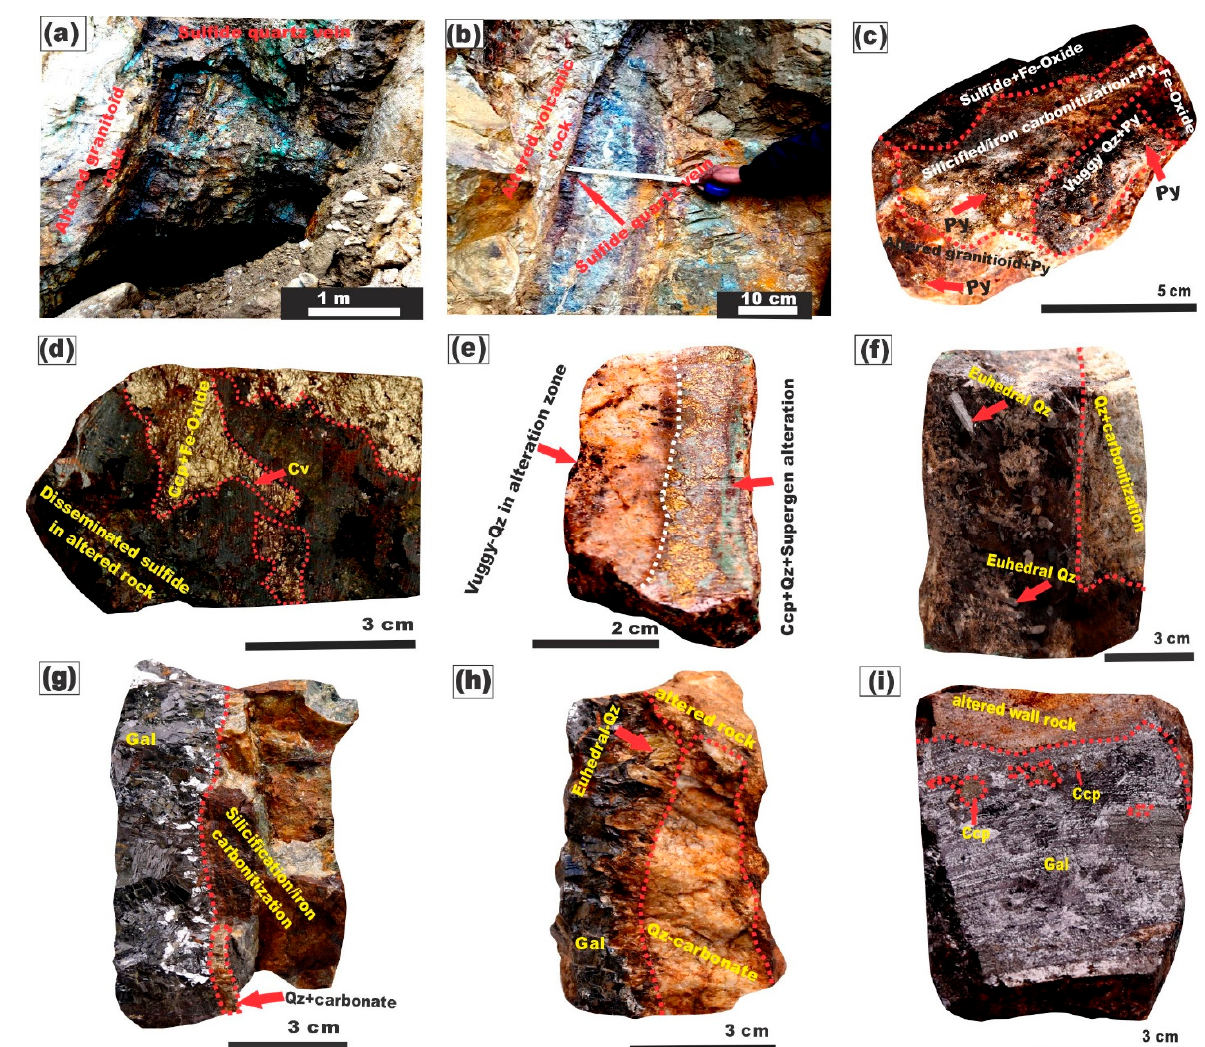
Figure 3. Photographs of representative mineralization types and textures: ( a ) Crustified-banding of zincian tetrahedrite- rich sulfide quartz vein cutting host rock (granitoids) along the fracture; ( b ) galena-rich quartz vein hosted by volcanic rock; ( c ) intensively altered sulfide-bearing granitoids at contact with sulfide vein; ( d ) massive chalcopyrite penetrating in metavolcanic rock (greenschist), covellite rim is visible around chalcopyrite; ( e ) copper-rich sample with the association of vuggy quartz and supergene alteration; ( f ) comb texture of euhedral early quartz in sulfide vein at wall rock contact; ( g ) corrugation structure of galena at the boundary of silicification/iron carbonatization; ( h ) gradational contact of quartz- carbonate and sulfide ore; ( i ) relict grains of chalcopyrite within massive galena. Py, pyrite; Ccp, chalcopyrite; Cv, covellite; Gal, galena; Fe, native iron; Qz, quartz.